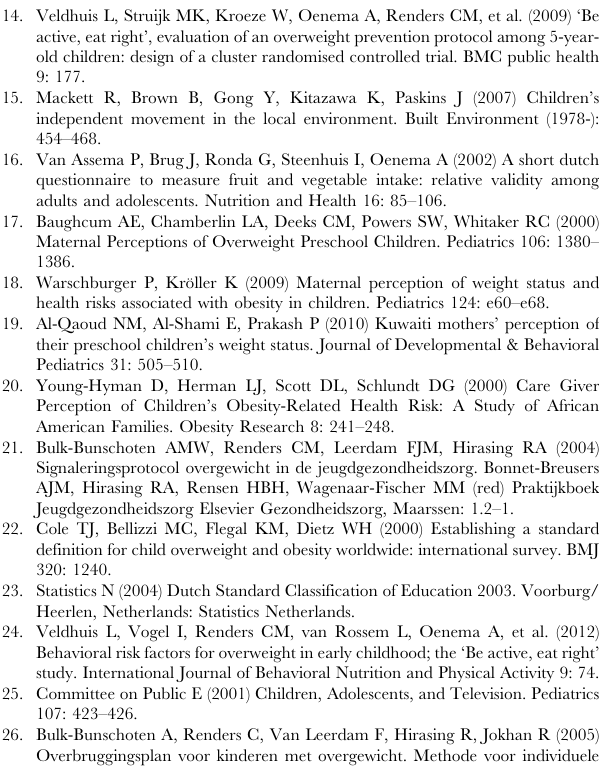
Table S1 Relative influence of potential confounders on the relationship between parental misperception, and 1) parental intention to improve child engagement in overweight-related health behaviors, and 2) child meeting guidelines regarding these behaviors. Table S2 Mixed model logistic regression analyses, presenting the association between parental misperception and 1) parental intention to improve child engagement in overweight-related health behaviors, and 2) child meeting guidelines regarding these